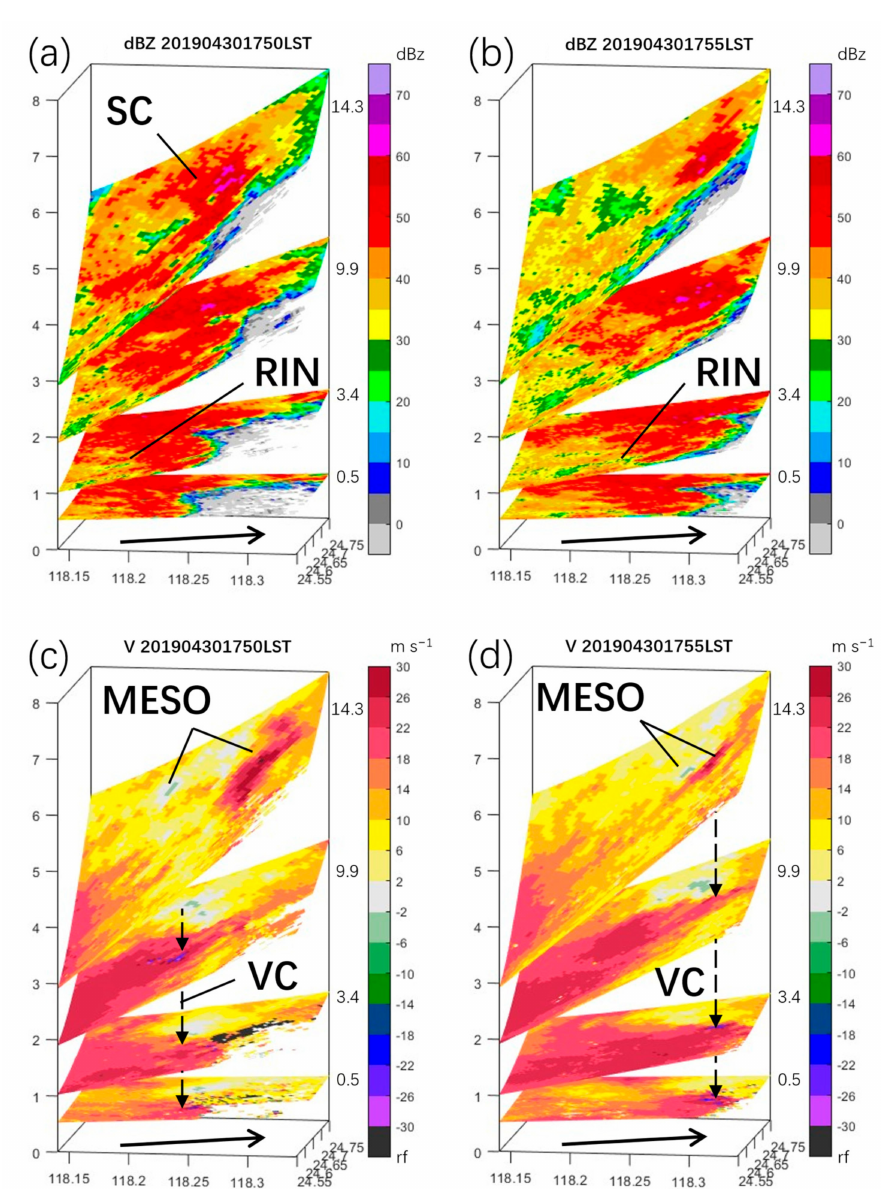
Figure 10. Reflectivity (shaded; unit: dBZ) structures of multiple PPIs (0.5 ◦ , 3.4 ◦ , 9.9 ◦ , and 14.3 ◦ ) at 17:50 LST ( a ) and 1755 LST ( b ). Doppler velocity (shaded; unit: m s − 1 ) structures of multiple PPIs (0.5 ◦ , 3.4 ◦ , 9.9 ◦ , and 14.3 ◦ ) at 17:50 LST ( c ) and 1755 LST ( d ). The black arrow indicates the moving direction of the system. Here, “SC” means mini-supercell, “RIN” refers to rear-inflow notch, “MESO” refers to mesocyclone, and “VC” (indicated by the dotted arrow) indicates velocity core in low-elevation